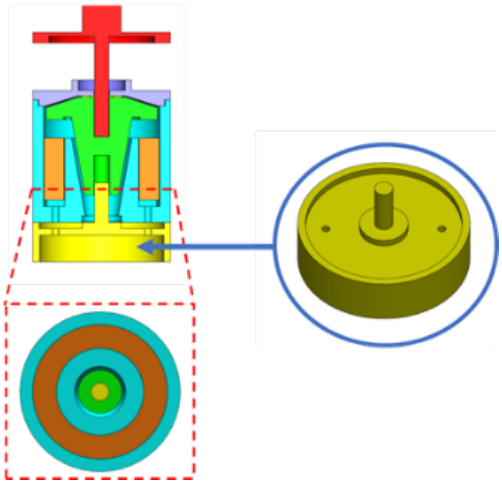
Figure 6. The simple design of the top plate.